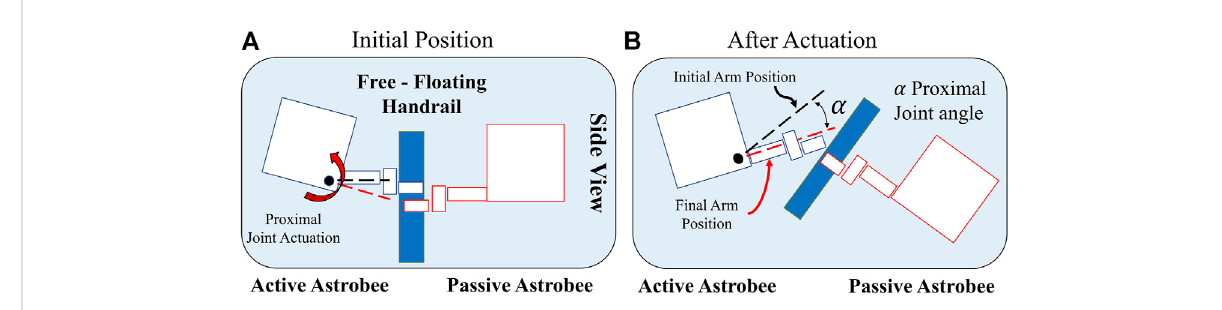
FIGURE 2 Astrobee hopping maneuver — side view: (A) Initial con fi guration with theproximal joint atinitial arm position. (B) Illustration after actuation and gripper release.